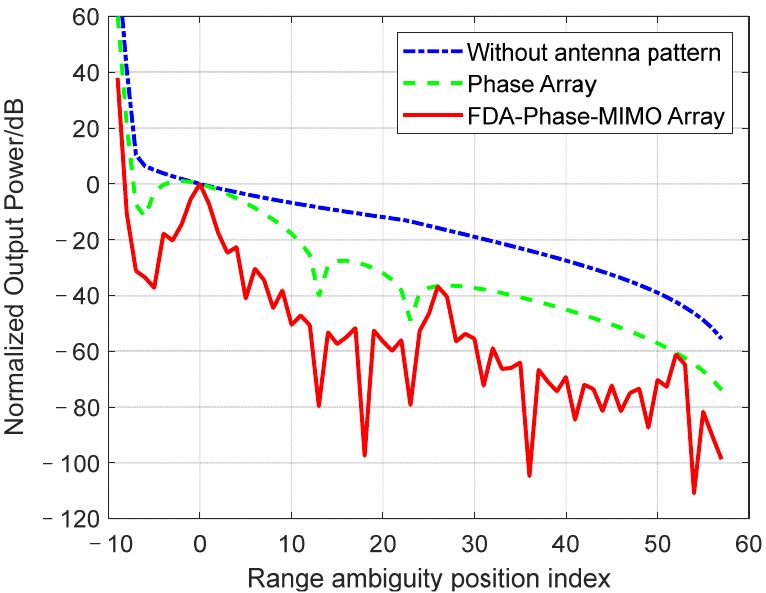
Figure 7. Normalized clutter power of clutter receiving units at different range ambiguous positions.